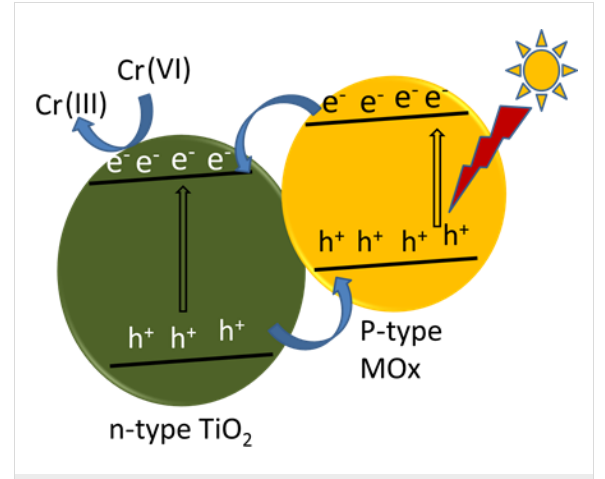
Figure 9: Mechanism for photocatalytic reduction of Cr(VI) by TiO 2 –MO x under irradiation of visible